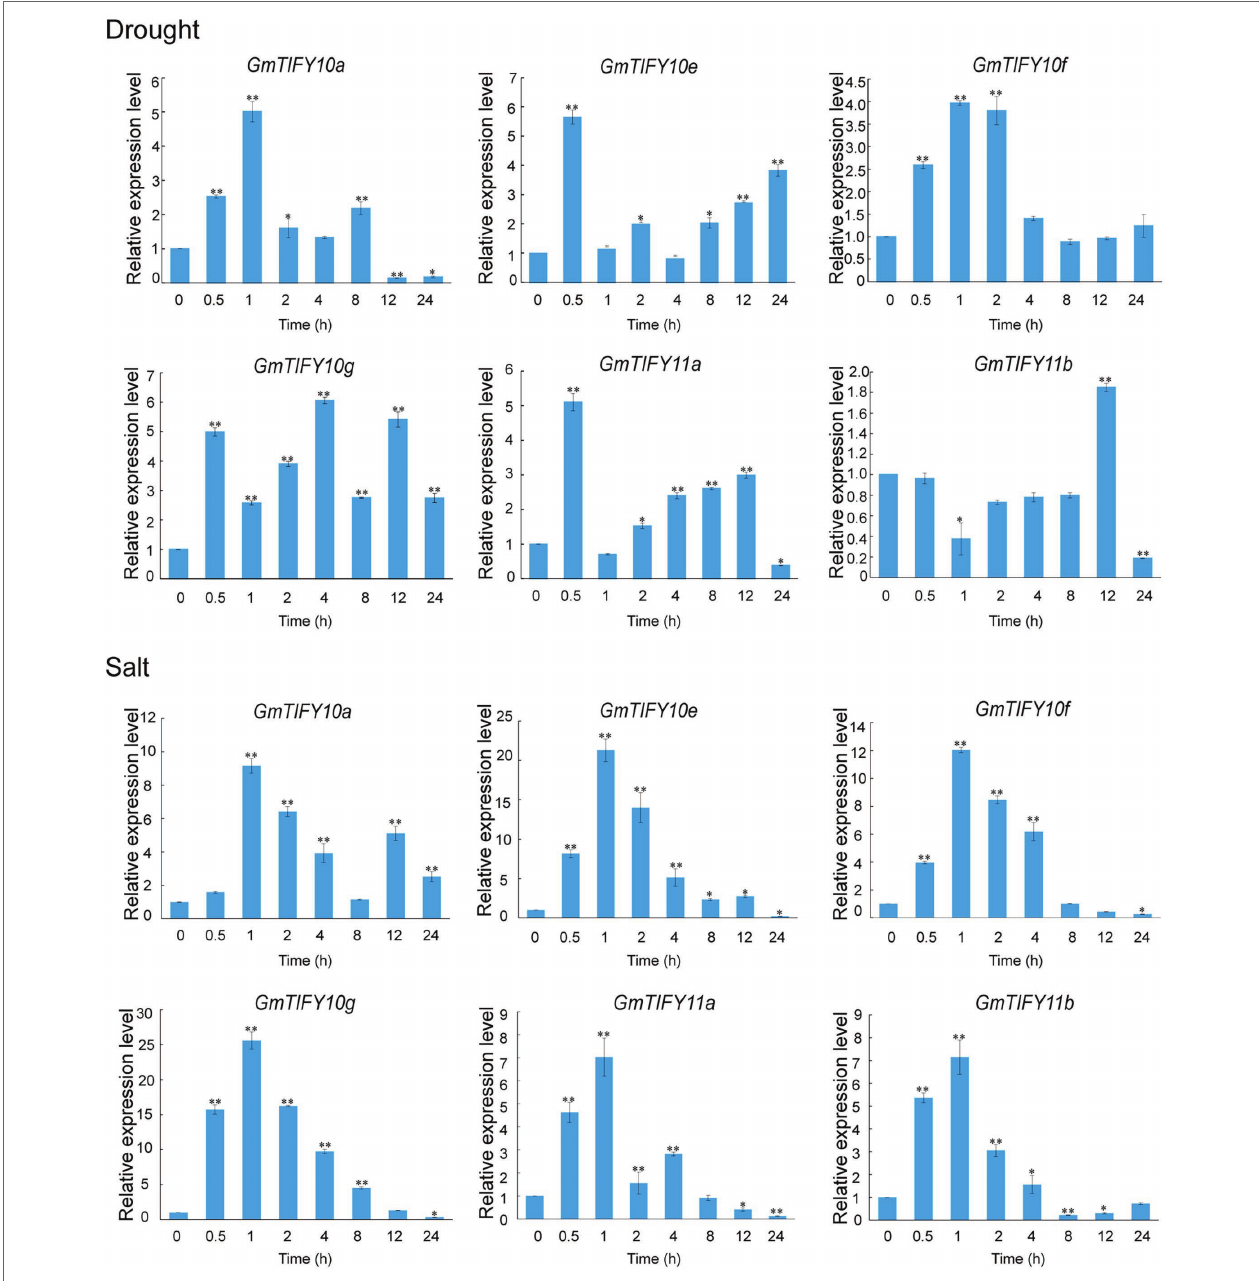
FIGURE 7 | Expression patterns of GmTIFY genes under drought and salt stress conditions. Expression levels of six GmTIFY genes were measured using RT- qPCR at different times under drought and salt treatments. RT-qPCR data were normalized using GmELF1b as the reference gene and were displayed relative to 0 h. The x -axes show the duration of treatment, and the y-axes depict relative expression levels (error bars indicate SD). The data are shown as the means of three biological replicates ±SD. ANOVA test demonstrates that there are significant differences ( * p < 0.05, ** p <